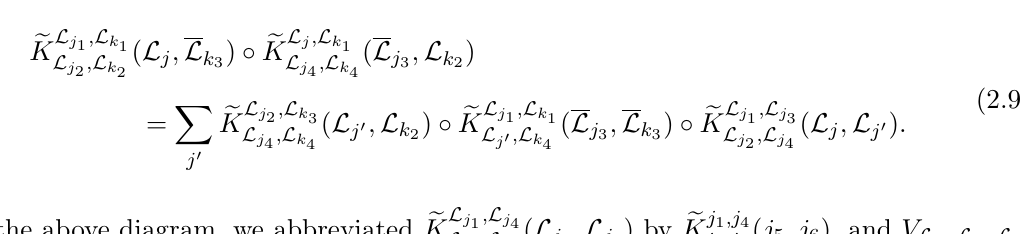
Figure 13 . The permuted crossing kernel e K . Note that the last legs at the T-junctions are marked di(cid:11)erently in comparison to the crossing kernel K de(cid:12)ned in (cid:12)gure 10. the permuted crossing kernels e K satisfy the pentagon